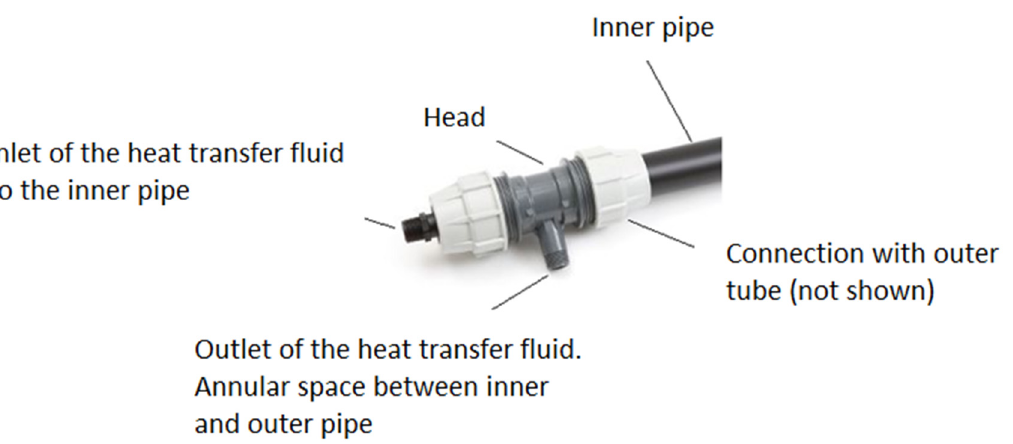
Figure 3. Inner tube of the coaxial pipe and connection head to the outer pipe and the heat transfer fluid circuit.